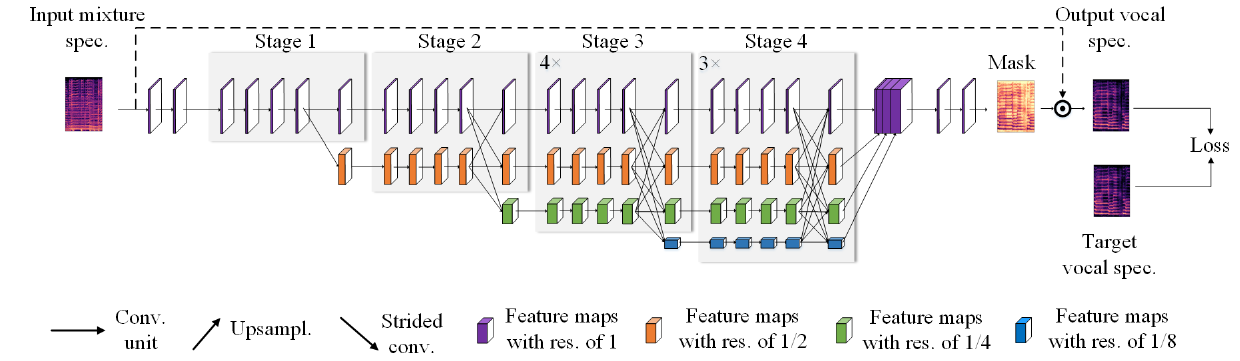
Figure 2. The architecture of the used high-resolution network (HRNet) for singing voice separation.